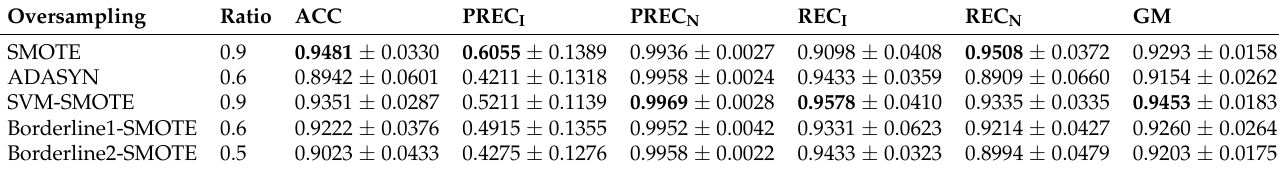
Table 3. Evaluation of SLFN- k -means++ k = 3 with different oversampling techniques.